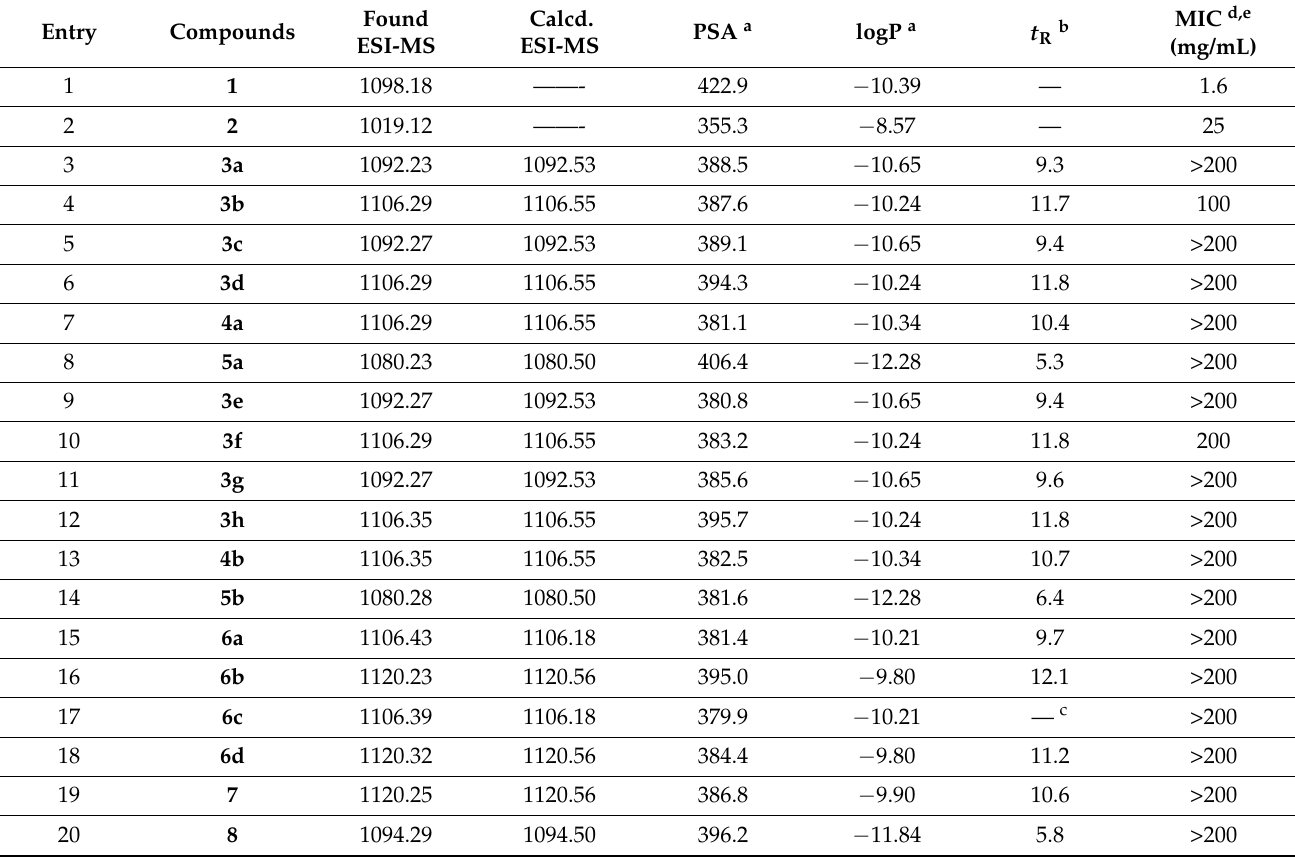
Table 2. The chemical properties and antifungal activity levels of the Bk